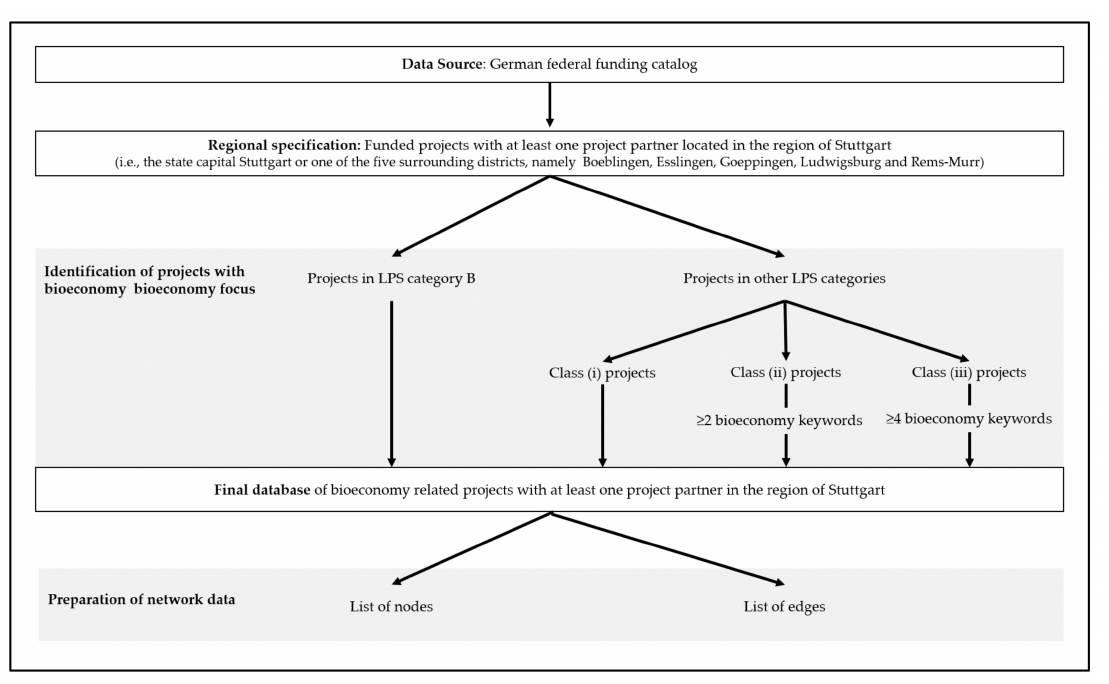
Figure 1. Data collection and preparation process. [Note: class (i) projects that can certainly be assigned to the bioeconomy, class (ii) projects that can partly be assigned to the bioeconomy, and class (iii) projects with a thematic focus that cannot be assigned to the bioeconomy are constructed according to Ref. [18].